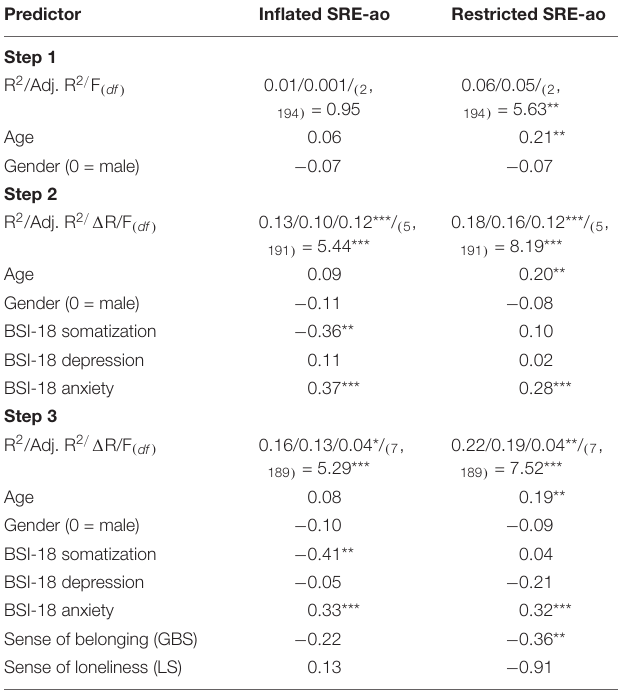
TABLE 2 | Prediction of inflated and restricted subscales of the SRE-ao by BSI-18 anxiety, depression, and somatization subscales, sense of belonging (GBS), and sense of loneliness (LS), when controlling for age and gender ( n = Inflated Restricted Mean (SD) SRE-ao SRE-ao